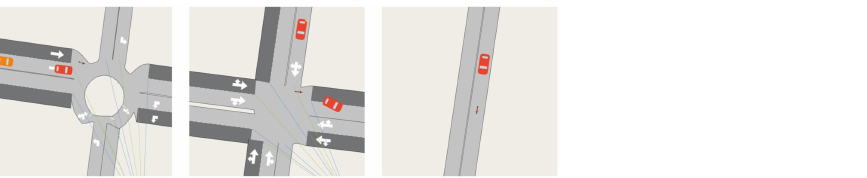
Figure 9. Street sections displaying interactions of bicycles and cars at a roundabout ( left ), intersection ( middle ) and at streets where space is shared for mixed traffic ( right ) during a